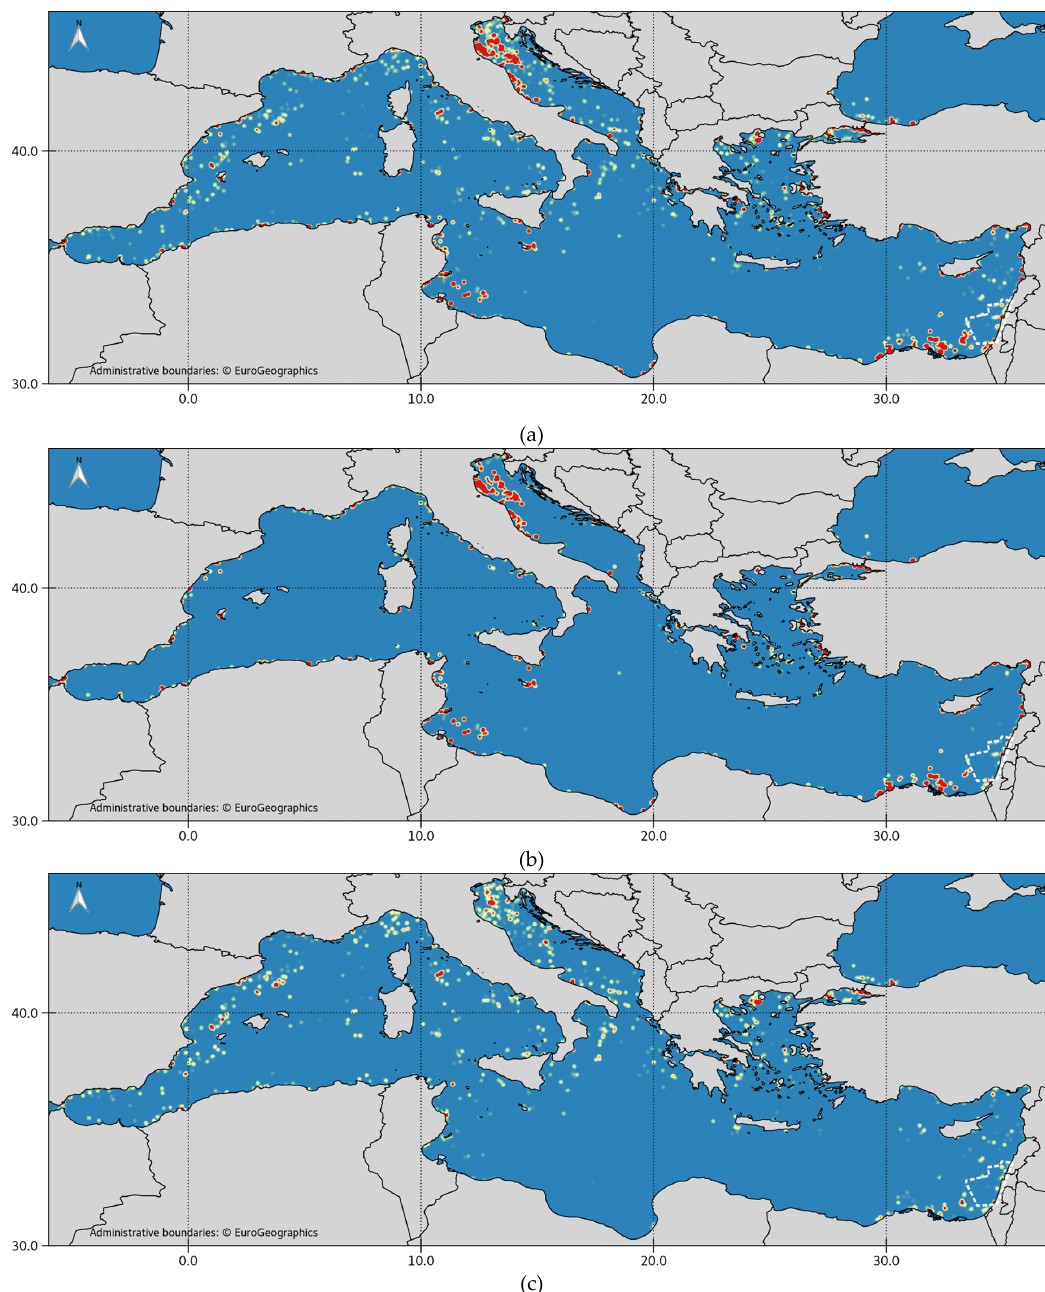
Figure 11 . Weighted maps of: ( a ) sources of recurrence (12,300); ( b ) sources classified as fixed structures (9565); and ( c ) sources classified as ambiguities (2735). In all maps, the sources of recurrence are weighted by the ratio between the number of images in which the source has been detected over the number of images in which the source could have been detected Area off Israel with high concentration of RFI-related detections is indicated as a white polygon.